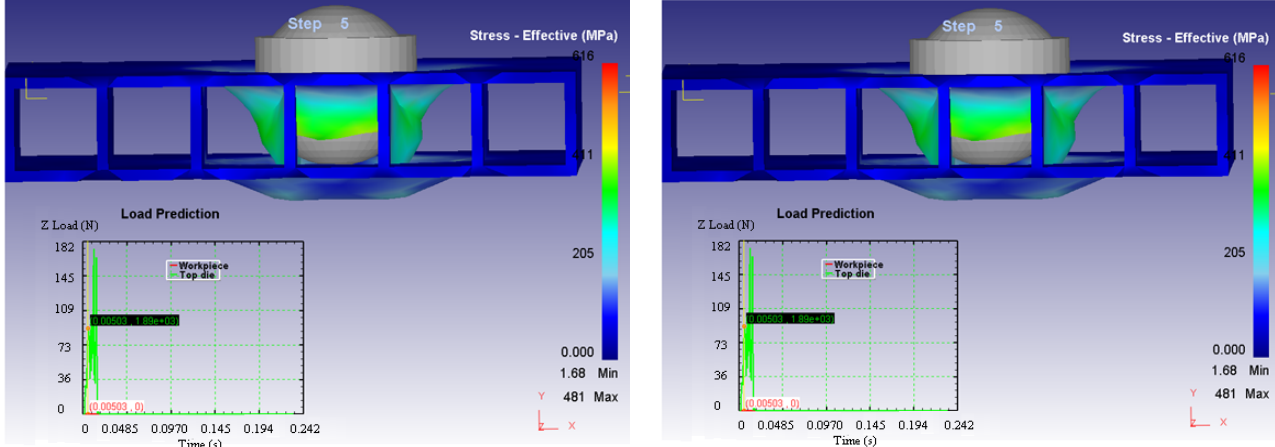
Figure 16. Stress-effective efforts—Z axes in the two considered Figure 16 . Stress-effective efforts—Z axes in the two considered cases . Figure 16 . Stress-effective efforts—Z axes in the two considered cases .